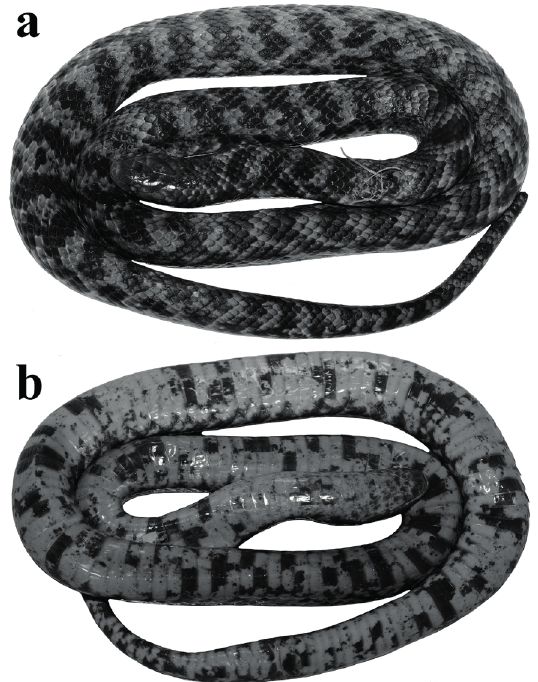
Figure 2 - dorsal ( a ) and ventral ( b ) views of body of the holotype of Atractus atlas sp. nov. (mePN 14203; SVl 820 mm, Cl 106 mm + N